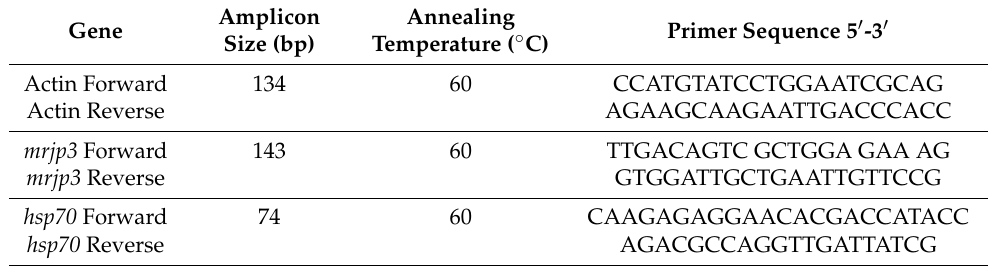
Table 1. Primers used for qRT-PCR and the respective amplicon sizes, annealing temperatures, and sequences. Amplicon Annealing Primer Sequence 5 (cid:48) -3 (cid:48) Gene Size (bp) Temperature ( ◦ C) Actin Forward 134 60